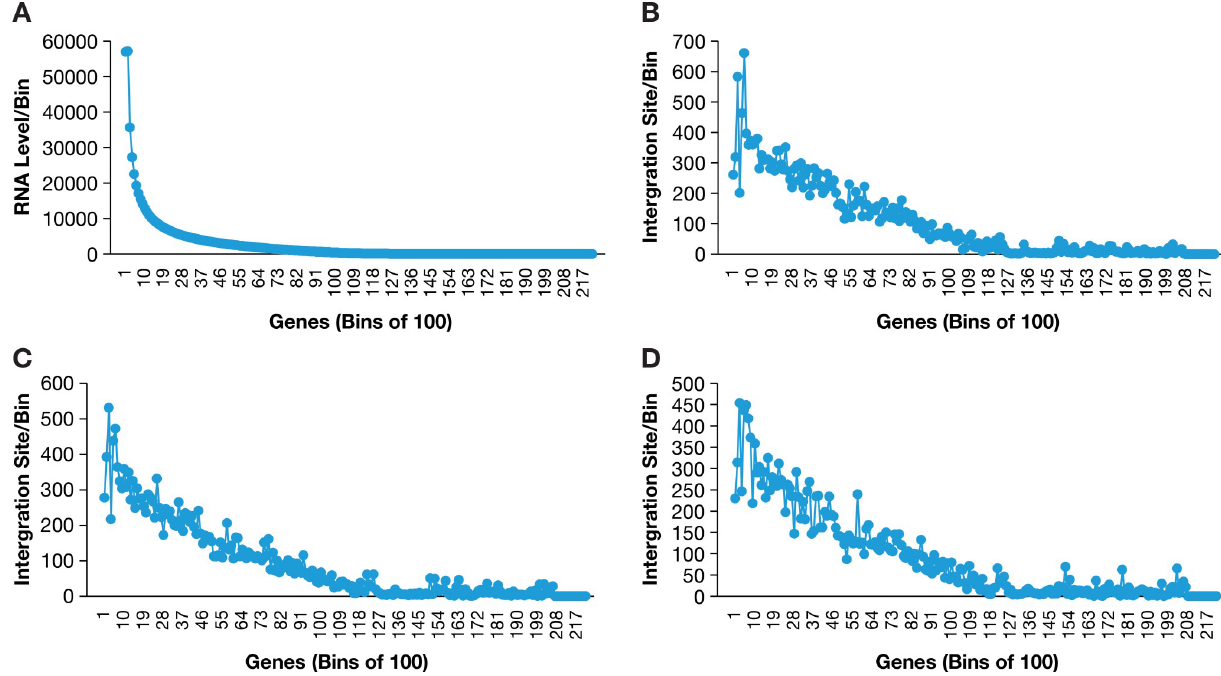
Fig 2. Both HIV and SIV preferentially integrate their DNA into highly expressed genes. Genes were placed in bins of 100, based on the levels of RNA in stimulated human PBMCs. Panel A shows the relative levels of RNA in each bin. Panel B shows the distribution of HIV integration sites in human PBMCs, placing the genes in the same bins as in panel A. Panel C shows the distribution of SIV integration sites in human PBMCs, using the same bins for the genes. Panel D shows the distribution of SIV integration sites into macaque PBMCs (the integration sites used in the analysis were mapped to the human